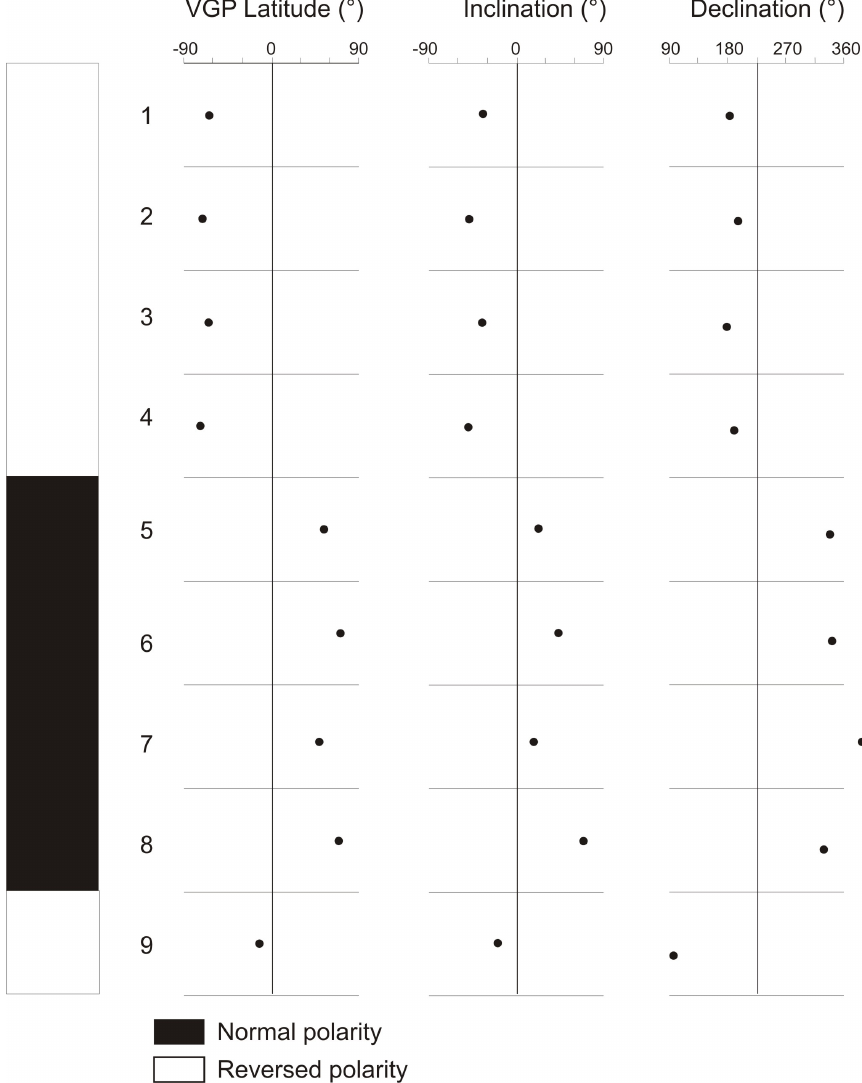
Figure 5. Paleomagnetic record. From left to right: polarity succession, latitude of the Virtual Geomagnetic Pole (VGP), magnetic Inclination and declination.